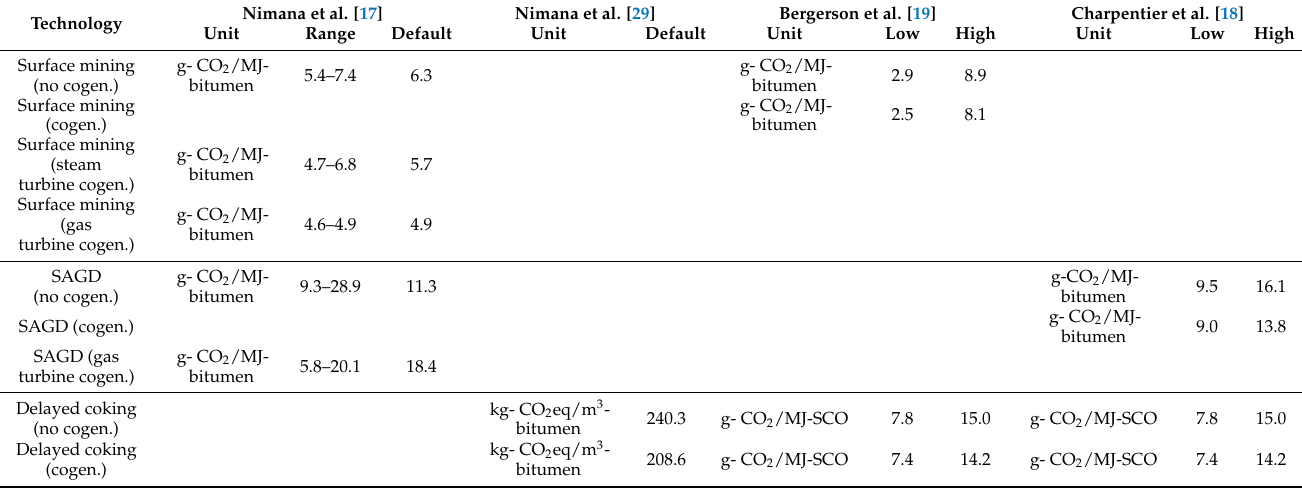
Table 2. Summary of CO 2 emission by oil sands